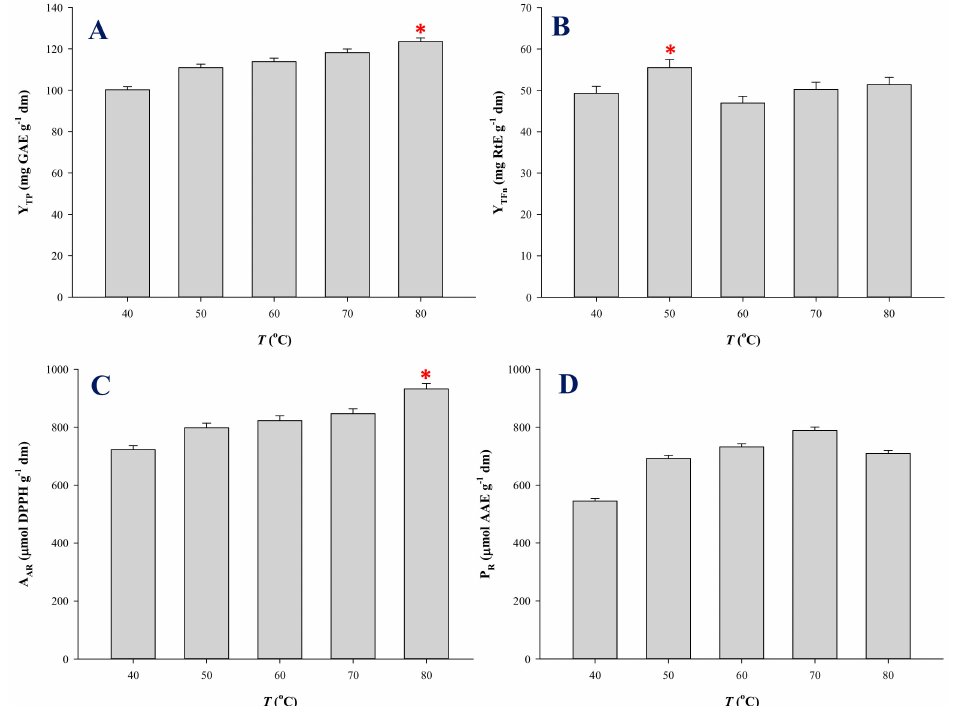
Figure 4. Bar diagram displaying the e ff ect of extraction temperature on the characteristics of the extracts obtained with LA-Gly (5:1), under optimal conditions. ( A ), yield in total polyphenols (Y TP ); ( B ), yield in total flavonoids (Y TFn ); ( C ), antiradical activity (A AR ); ( D ), reducing power (P R ). Asterisk (*) indicates statistically di ff erent value ( p <